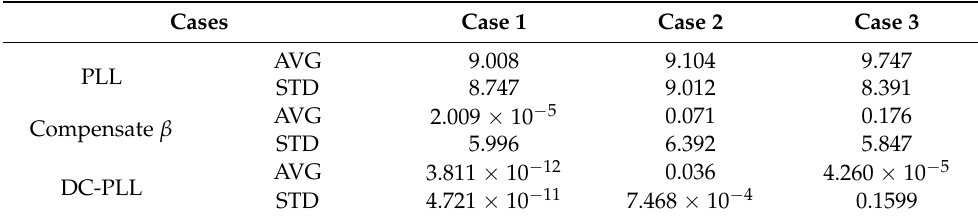
Figure 8. Demodulation errors at fixed speed in simulation. ( a ) Position estimation error; ( b ) velocity estimation error. Table 1. The statistics of position estimation error ( (cid:101) θ ( (cid:48) )